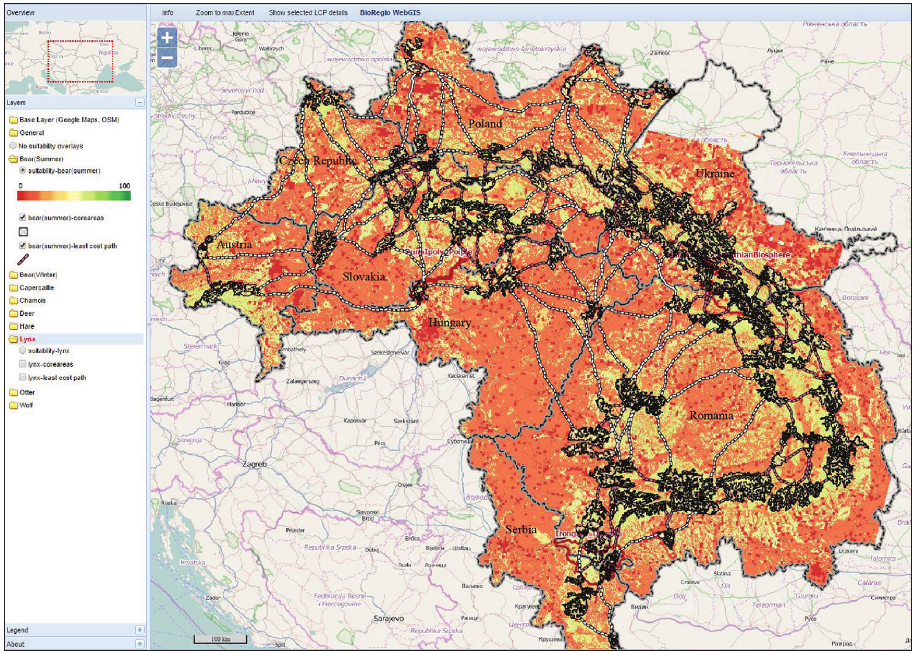
Figure 7. Web-GIS screenshot of the potential suitability map, core areas (black polygons) and least cost paths (dotted lines) for the Bear (Summer Model) in the